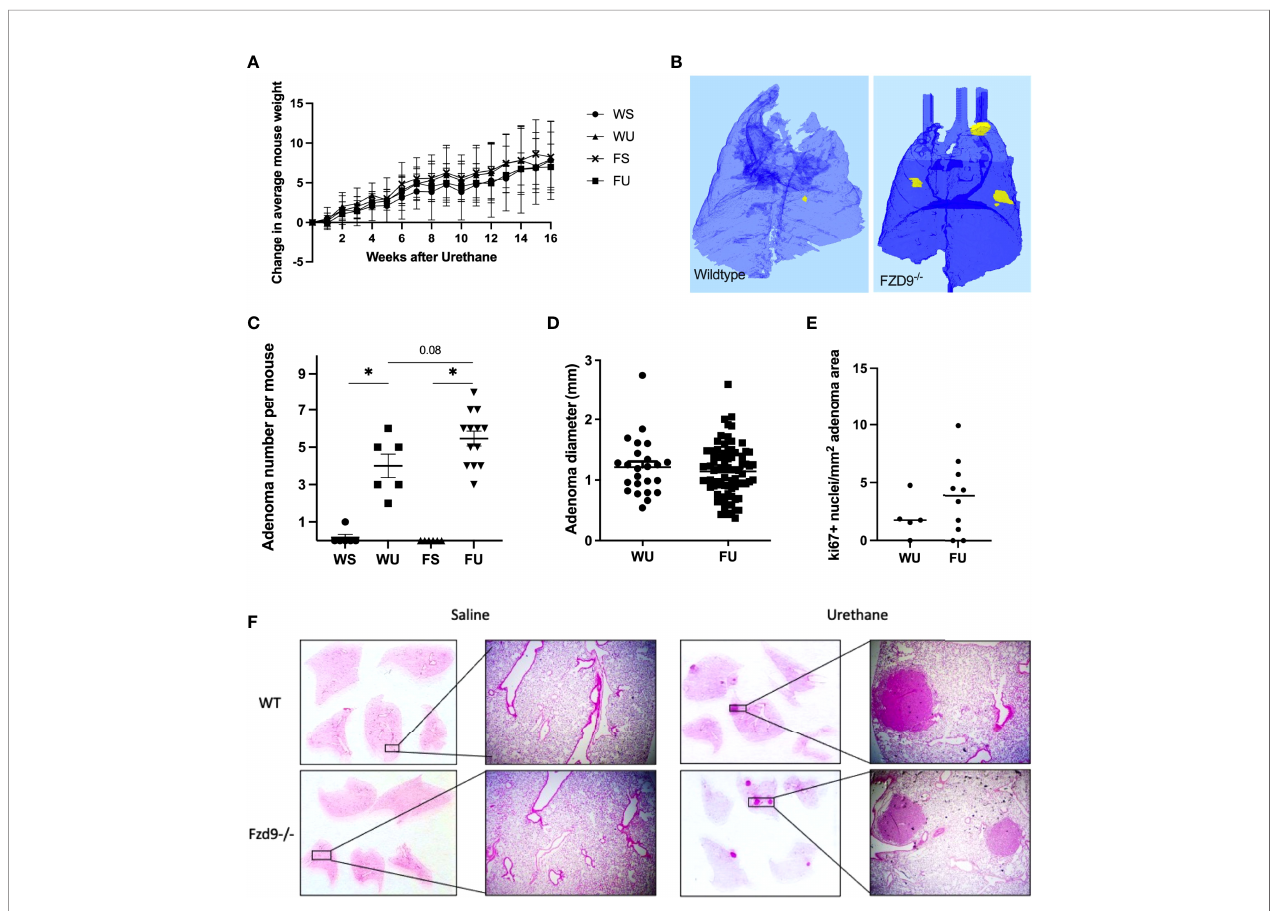
FIGURE 2 | Loss of FZD9 increases adenoma multiplicity in vivo . (A) Mice were weighed weekly after urethane exposure and average change each week was calculated for each group. (B) Representative microCT image of wild type and FZD9 -/- mouse lungs 16 weeks after urethane exposure. Yellow indicates presence of an adenoma. (C) Wild type and FZD9 -/- mice were exposed to 16 weeks of urethane or saline control and lesions were counted after sacri fi ce. Statistical signi fi cance was measured by one way ANOVA with Tukey ’ s post hoc analysis and *p<0.05. (D) The diameter of each lesion was measured and compared between wild type and FZD9 -/- mice. (E) Positive Ki-67 nuclei per mm 2 lesion area from adenomas in wild type or FZD9 -/- mice exposed to urethane. (F) Representative H&E stains of whole lungs and 10x magni fi cation from each group. WS, wild type saline; WU, wild type urethane; FS, FZD9 -/- saline; FU, FZD9 -/-